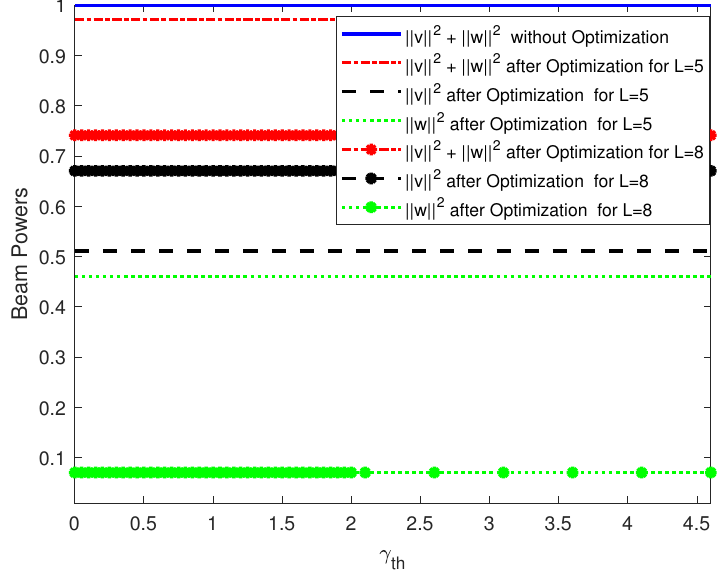
Figure 3. Optimization performance for beam powers with L = 5 and L = 8.